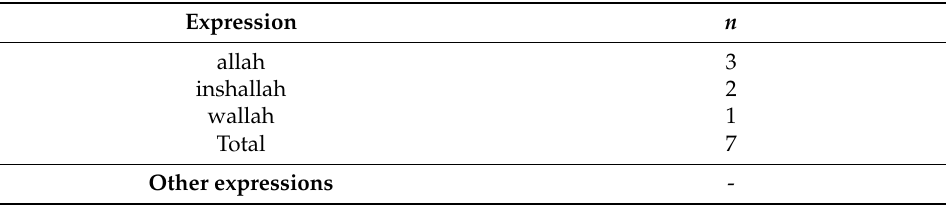
Table 8. Presenter Aim é e.